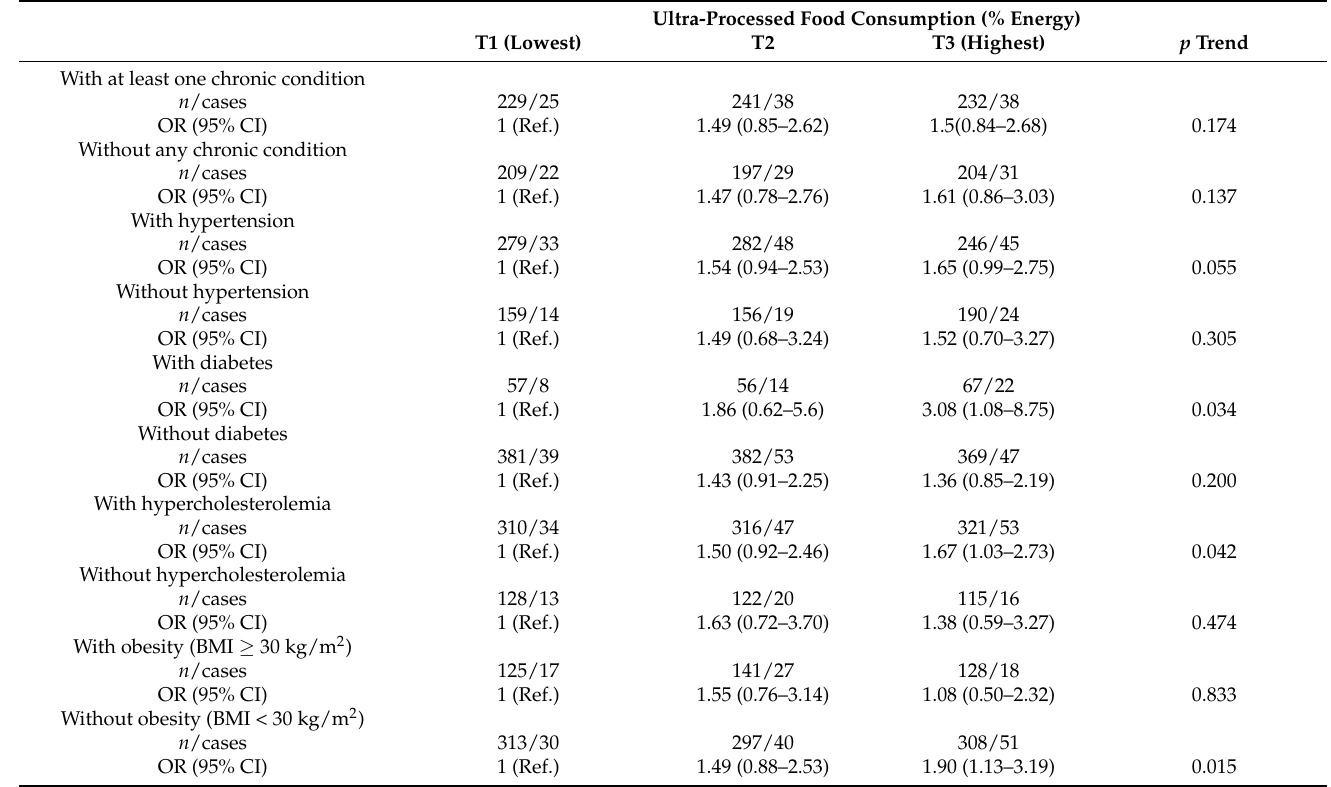
Table 3. Association between the consumption of ultra-processed food expressed as a percentage of total energy (% energy) and the risk of renal function decline after 6-year of follow-up (2008/10–2015) ( n = 1312) according to morbidity and several cardiovascular risk